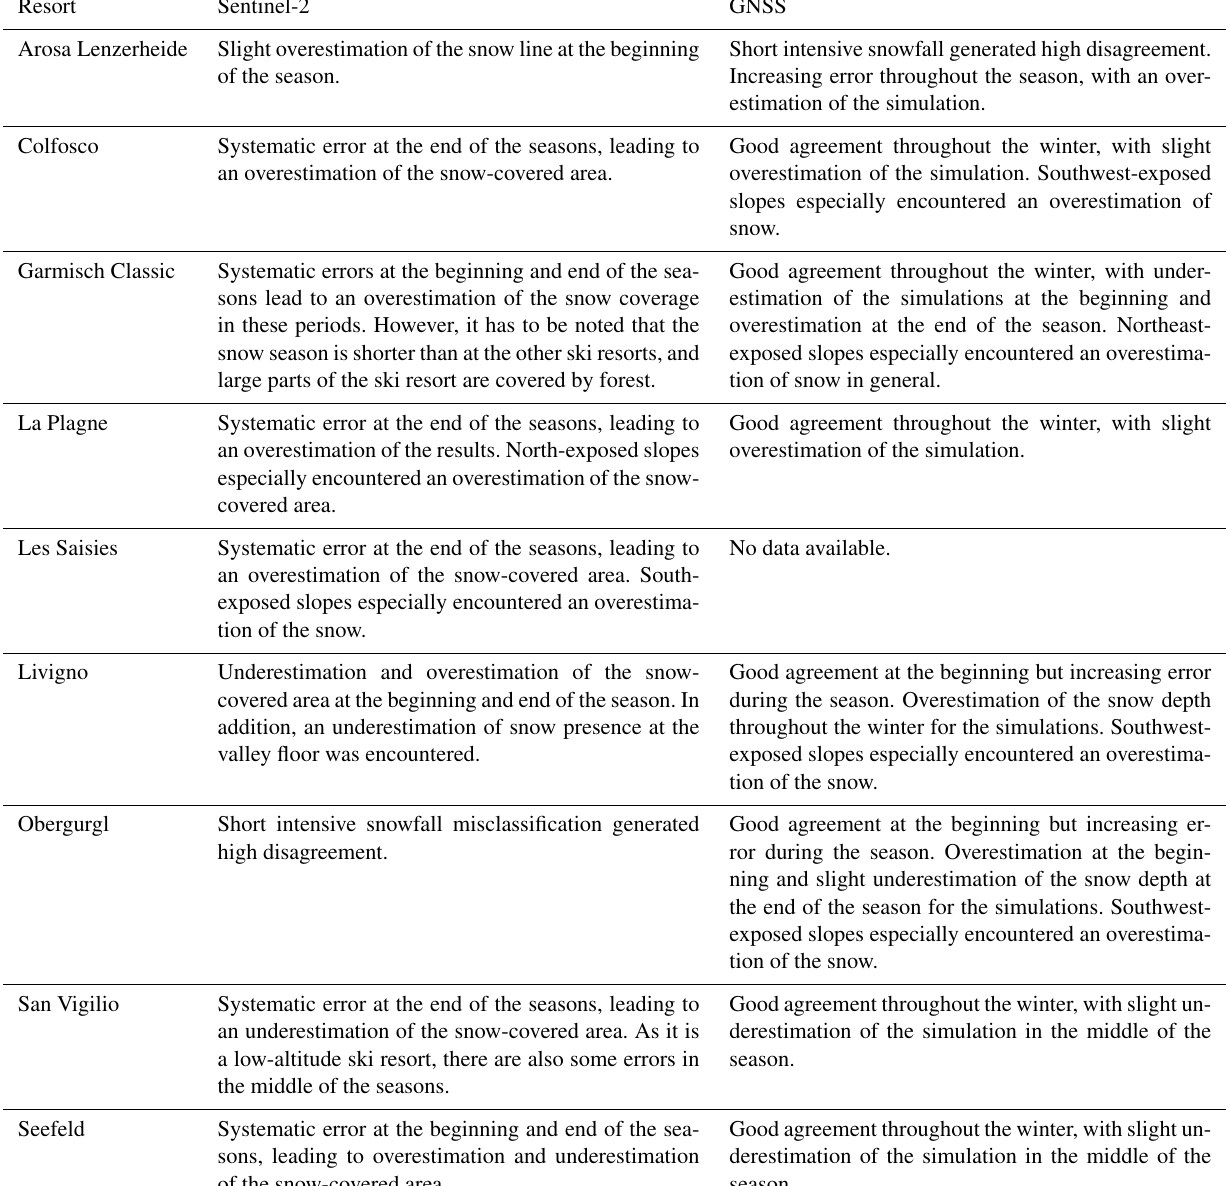
Table A3. Inter-comparing the model simulations with Sentinel-2 data and GNSS-measured snow depth for each ski resort. Resort Sentinel-2 GNSS Arosa